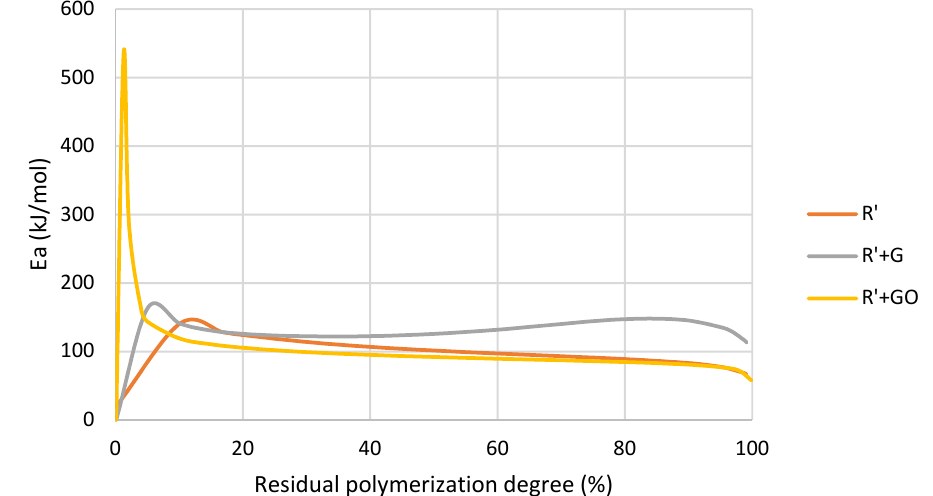
Figure 11. Conversion curves at 10 °C/min of R’ and R’+GBN after UV exposure.